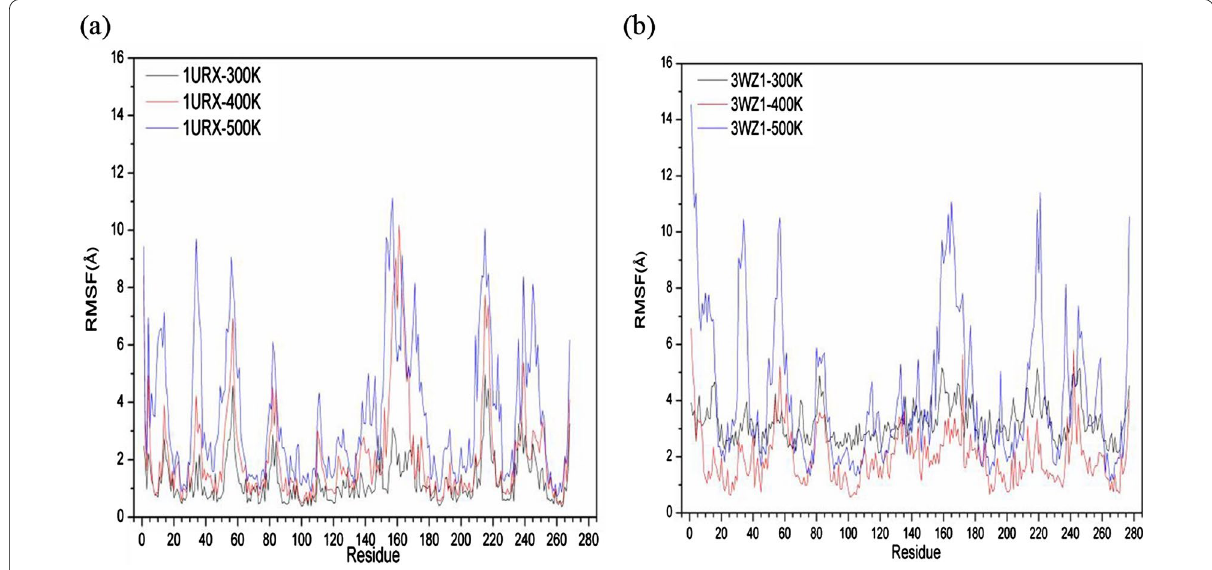
Fig. 3 Fluctuations of RMSF for 1URX ( A ) and 3WZ1 ( B ) under different